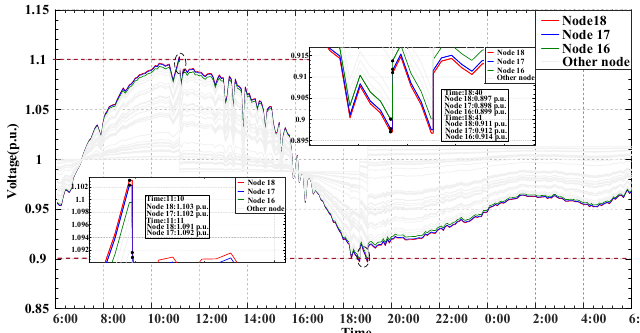
Figure 7. The voltages curves after regulation by the OLTC.